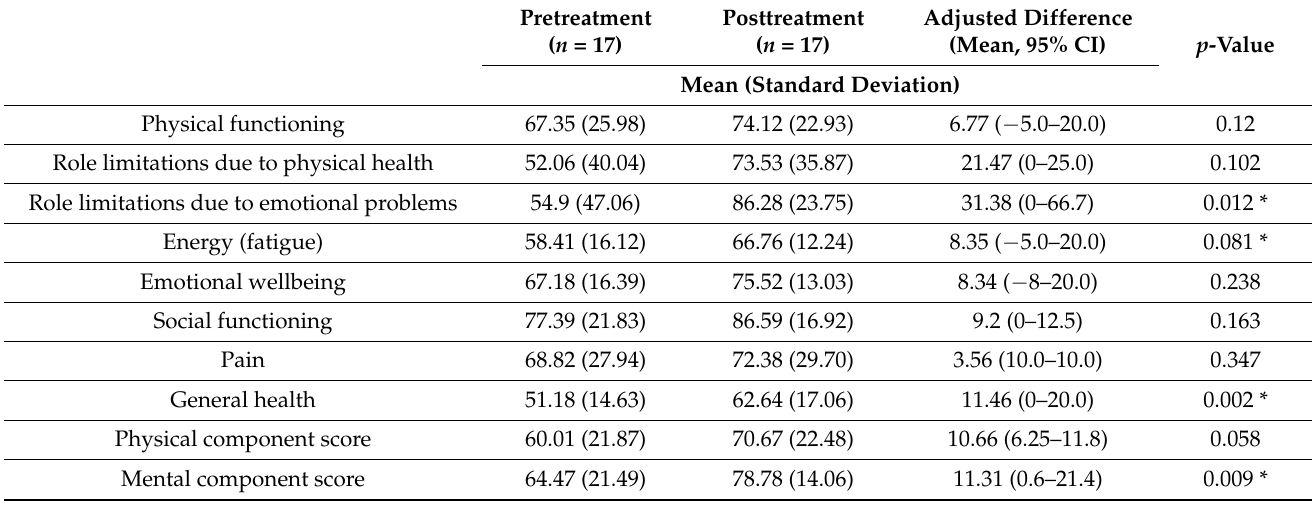
Table 3. SF-36 domains at baseline (pretreatment) and after 3 months of CPAP treatment (posttreatment).